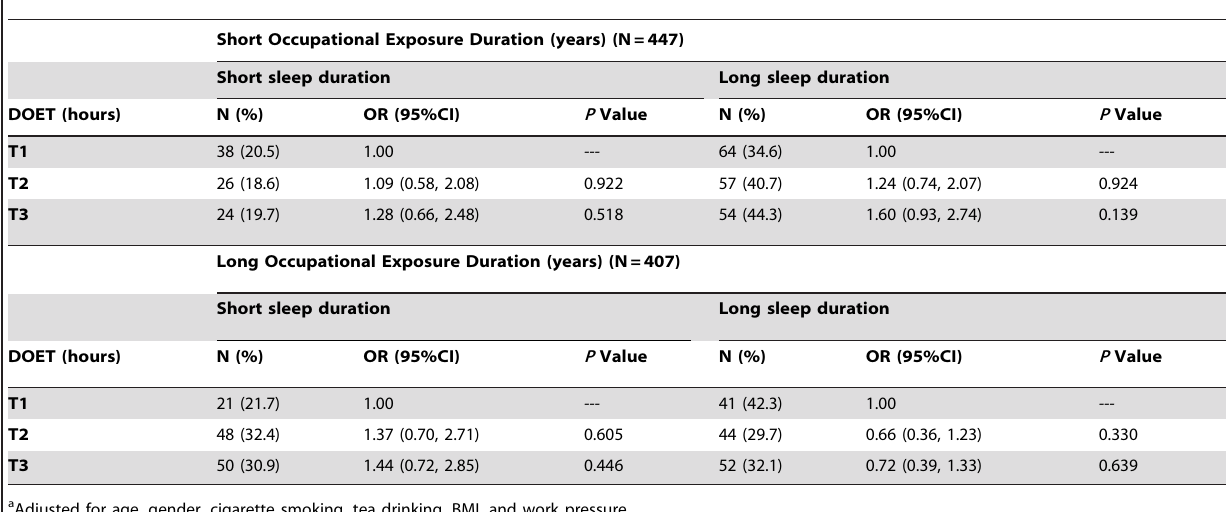
Table 5. The associations a of daily occupational exposure time (DOET) b with sleep duration stratified by occupational exposure duration c